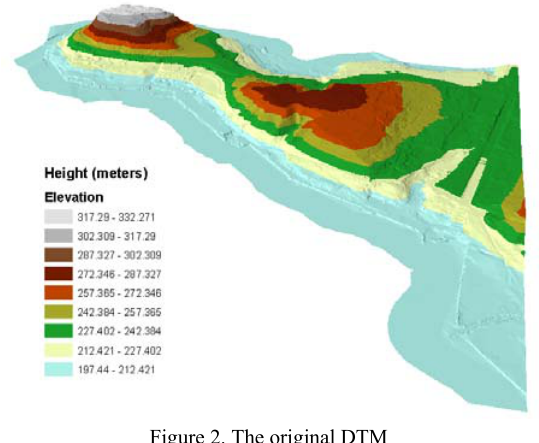
Figure 2. The original DTM